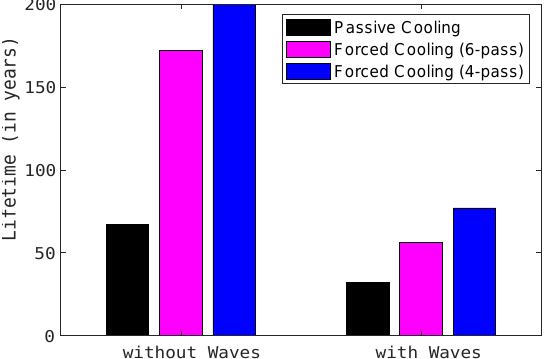
Figure 18. Estimated lifetime of the IGBT modules on the generator side converter with different cooling